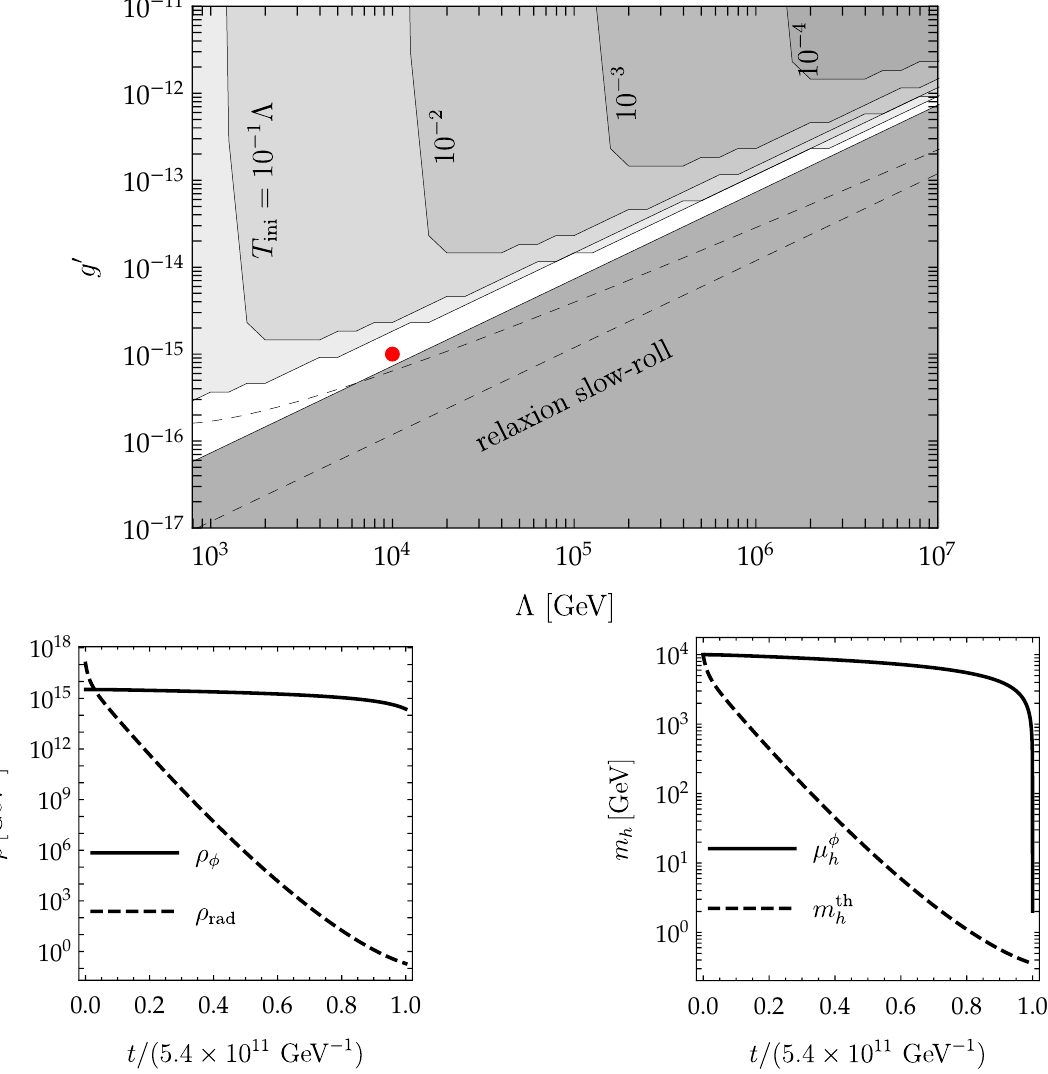
Figure 3 . Top: in the white region, the temperature T of the visible universe (SM) is suppressed with respect to the EW scale and the relaxation lasts less than 20 e-folds. It is obtained by solving numerically the relaxion equation of motion in a universe where the energy is initially equipartioned between the relaxion and radiation, and the initial temperature is T ini = (cid:3). The dashed lines indicate the corresponding region obtained using the approximation eq. (2.9). The di(cid:11)erent shades of gray show how the parameter space opens up if T ini is assumed to be a fraction 10 (cid:0) 1 ; 10 (cid:0) 2 ; 10 (cid:0) 3 ; 10 (cid:0) 4 of the cuto(cid:11) scale (cid:3). Bottom left: time evolutions of the relaxion energy density and radiation energy density for the benchmark point (cid:3) = 10 4 GeV, g 0 = 10 (cid:0) 15 , marked in red in the top panel. Bottom right: time evolutions of the Higgs mass term and the Higgs thermal mass for the same benchmark point.